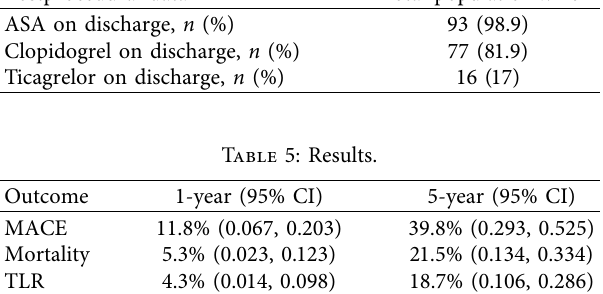
Figure 3: Time to